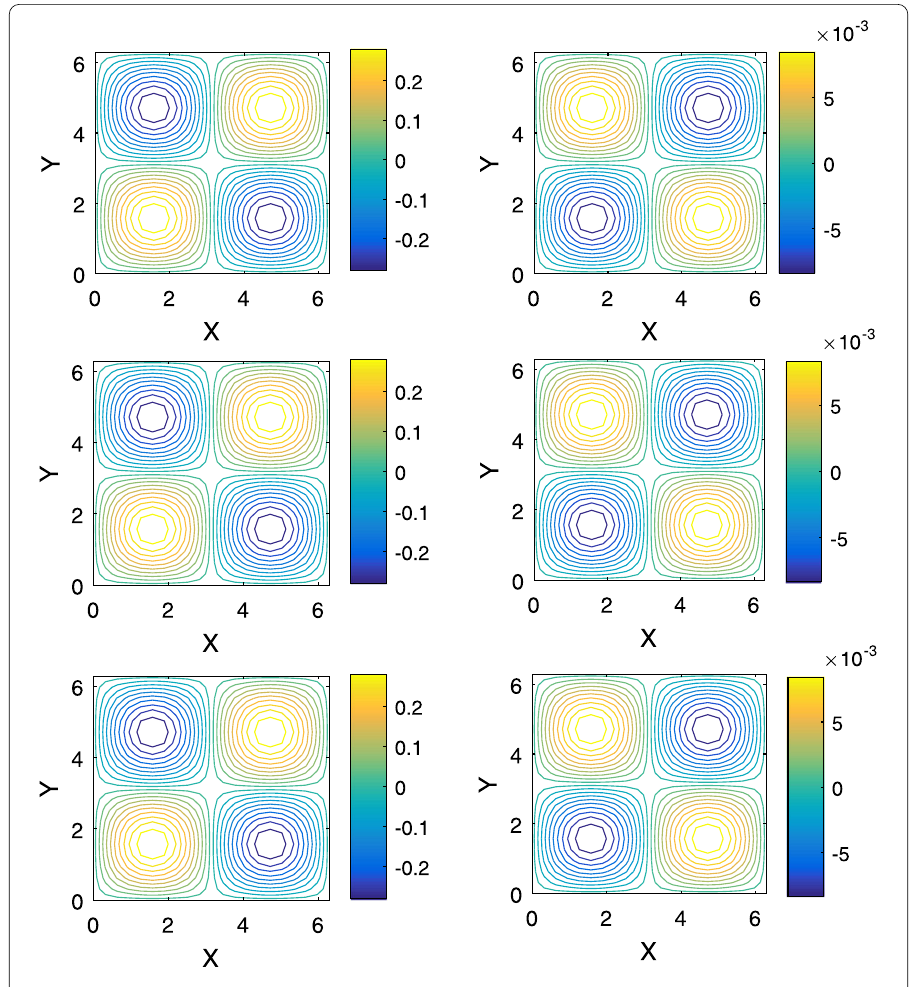
Figure 1 The contour plot of exact solution and numerical solutions to Example 1 at T = 0.01, z = 0.5 with N = 100 and M = 20. Left panel for real part and right panel for imaginary part correspond to the